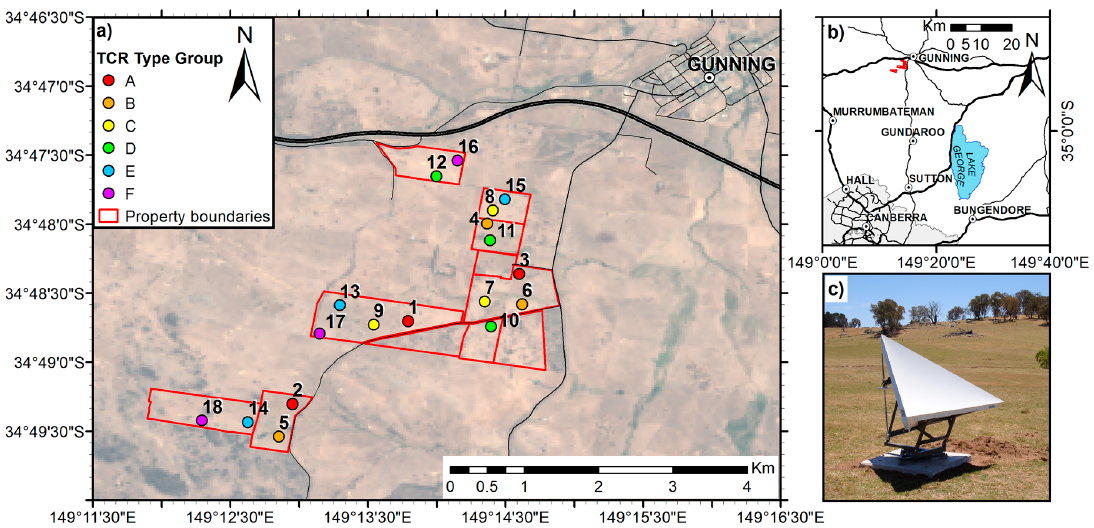
Figure 6. ( a ) Map showing the 18 TCR deployment sites at the Gunning test site coloured by type group (Table 2). The background image is a Landsat-8 RGB-composite optical image acquired on 15 January 2014 with 30 m pixel resolution. Red polygons outline the boundaries of the property available for the experiment. ( b ) Overview map showing the location of the Gunning test site (red polygons) in relation to Canberra, Australia; ( c ) photo of TCR number 7 as deployed at the Gunning test site.